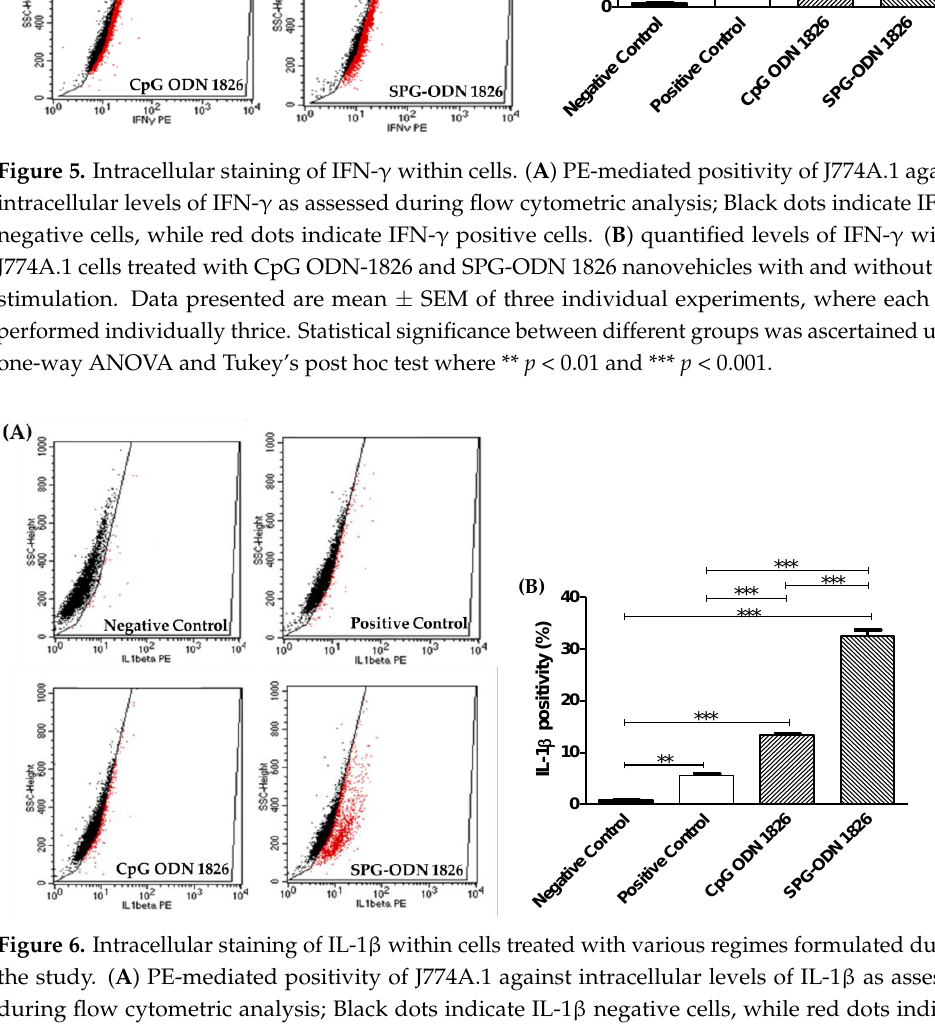
Figure 6. Intracellular staining of IL-1 β within cells treated with various regimes formulated during the study. ( A ) PE-mediated positivity of J774A.1 against intracellular levels of IL-1 β as assessed during flow cytometric analysis; Black dots indicate IL-1 β negative cells, while red dots indicate IL-1 β positive cells. ( B ) quantified levels of IFN- γ within J774A.1 cells treated with CpG ODN-1826 and SPG-ODN 1826 nanovehicles with and without LPS stimulation. Data presented are the mean ± SEM of three individual experiments, where each was performed individually thrice. Statistical significance between different groups was ascertained using one-way ANOVA and Tukey’s post hoc test where ** p < 0.01 and *** p < 0.001.